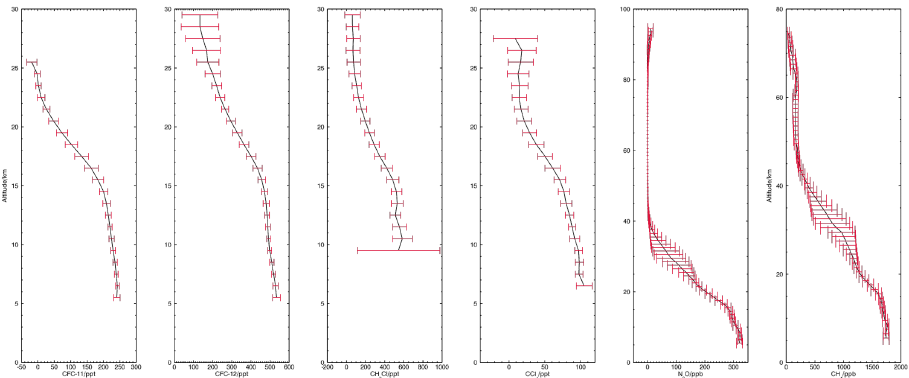
Figure C10 The mean vertical profile of CFC-11, CFC-12, CH3Cl, CH4 & N2O, calculated using data from 2009 between 45° and 60° South Fig. C11. The mean vertical profile of CFC-11, CFC-12, CH 3 Cl, CCl 4 , N 2 O and CH 4 , calculated using data from 2009 between 45 ◦ and 60 ◦ S.